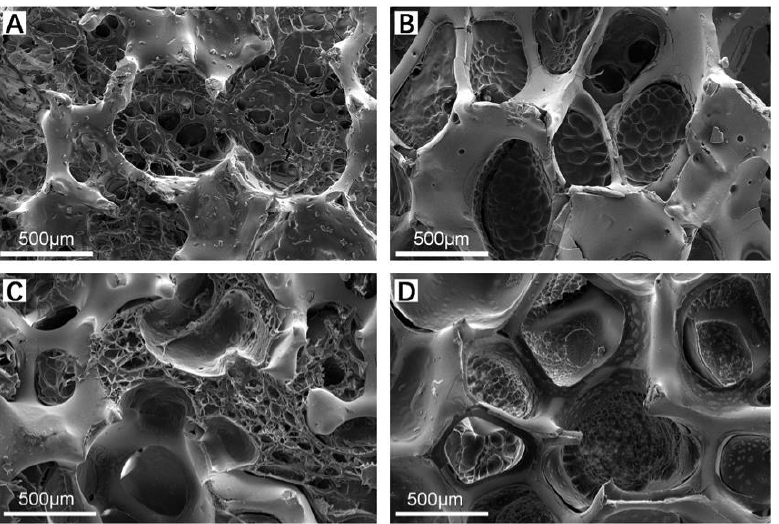
Figure 4. SEM images of ZrO 2 – GelMA composite scaffold . ( A ) ZrO 2 — 5% GelMA; ( B ) ZrO 2 — 10% GelMA; ( C ) ZrO 2 — 15% GelMA; and ( D ) ZrO 2 — 20% GelMA.